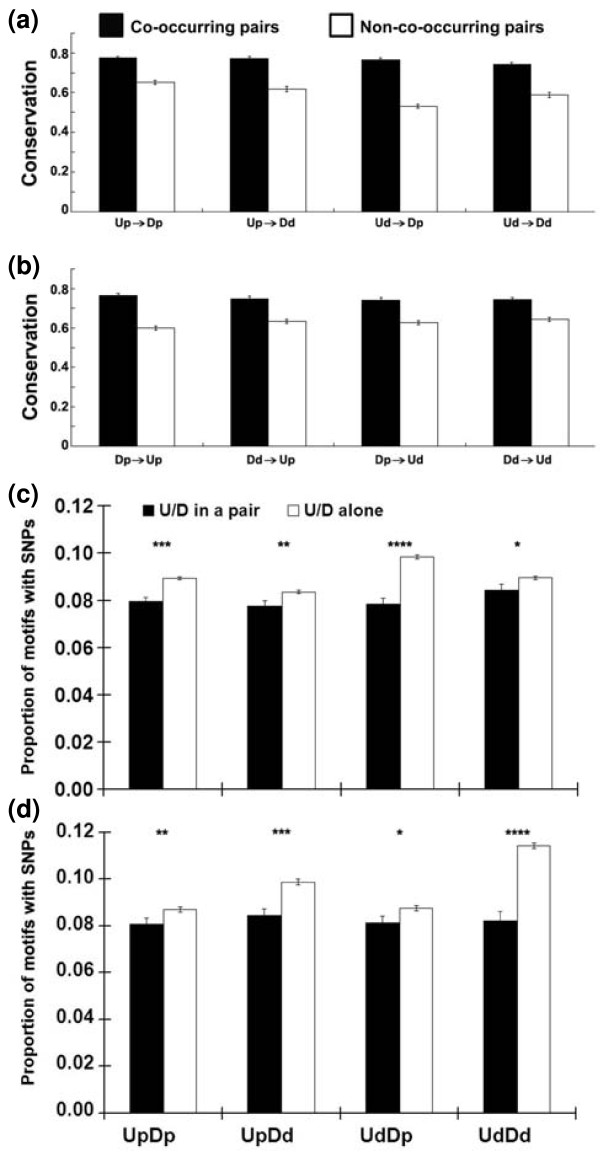
Co-occurring pairs are conserved in evolution. (a) Conservation of motif pairing in human and macaque. Conservation is defined as the proportion of orthologous constitutive exon pairs in which the upstream motif of a pair has been conserved given the conservation of a downstream motif (filled bars). The control (open bars) scored the conservation of non-co-occurring motif pairs (see text). (b) As (a), but in the other direction, scoring the conservation of the downstream motif given the conservation of the upstream motif. (c) Lower SNP density in intronic motifs of co-occurring pairs around constitutive exons. (d) Lower SNP density in intronic motifs of co-occurring pairs around alternative exons. The proportions of motifs containing SNPs were examined for the same set of motifs either when part of a co-occurring pair or when alone. Error bars are the standard error of the mean. *P < 0.05; **P < 0.01; ***P < 10-7; ****P < 10-13.